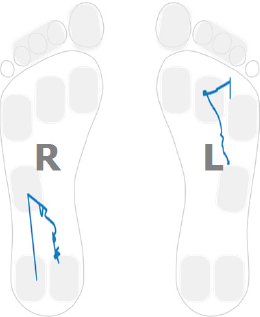
Figure 3. Post-stroke survivor. R: right; L: left.